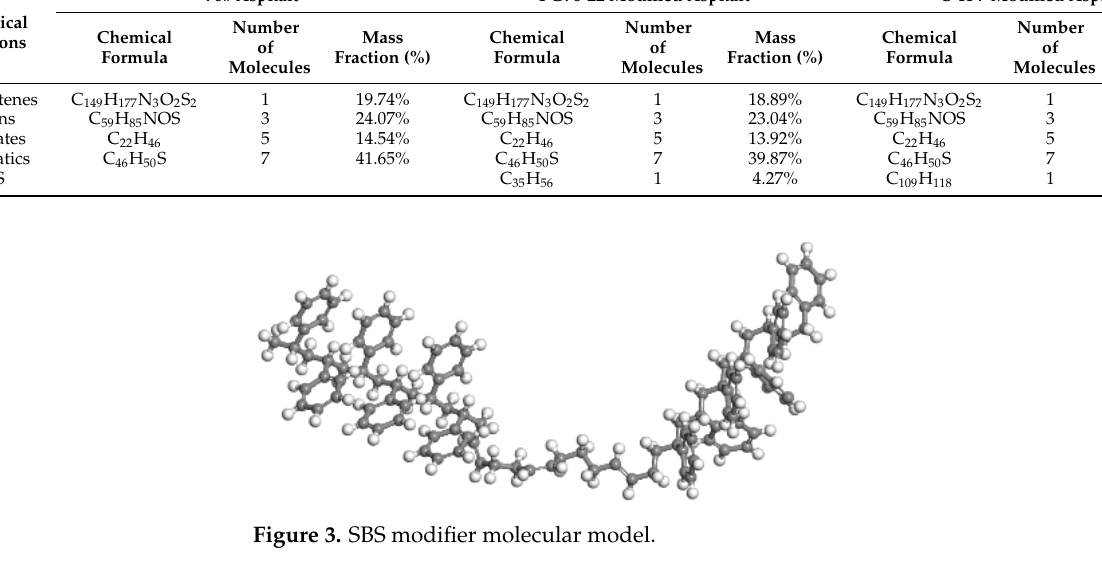
Figure 2. Structure of unit cell of four-component asphalt.